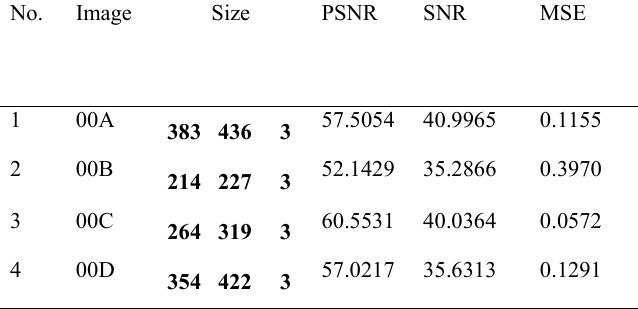
Table 2. Implementation of the algorithm for general color iris